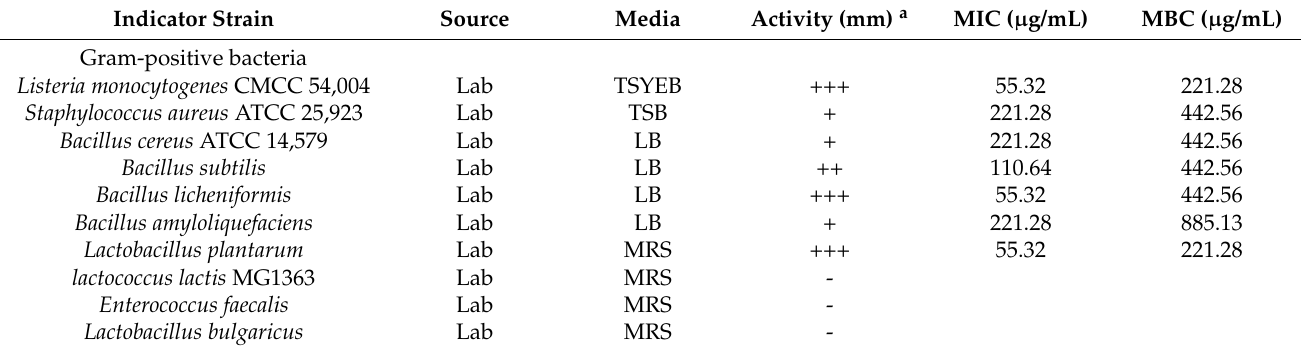
Table 1. Antibacterial spectrum of the crude bacteriocin of W. coagulans